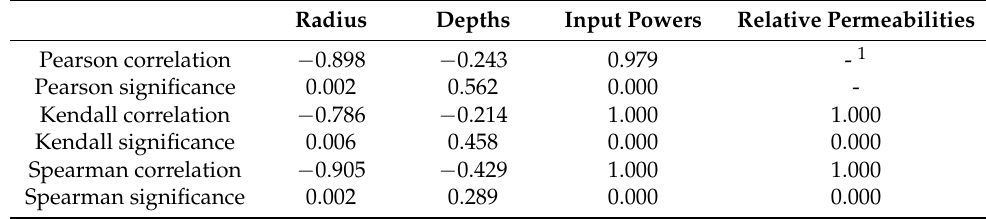
Table 2. Correlation analysis results.